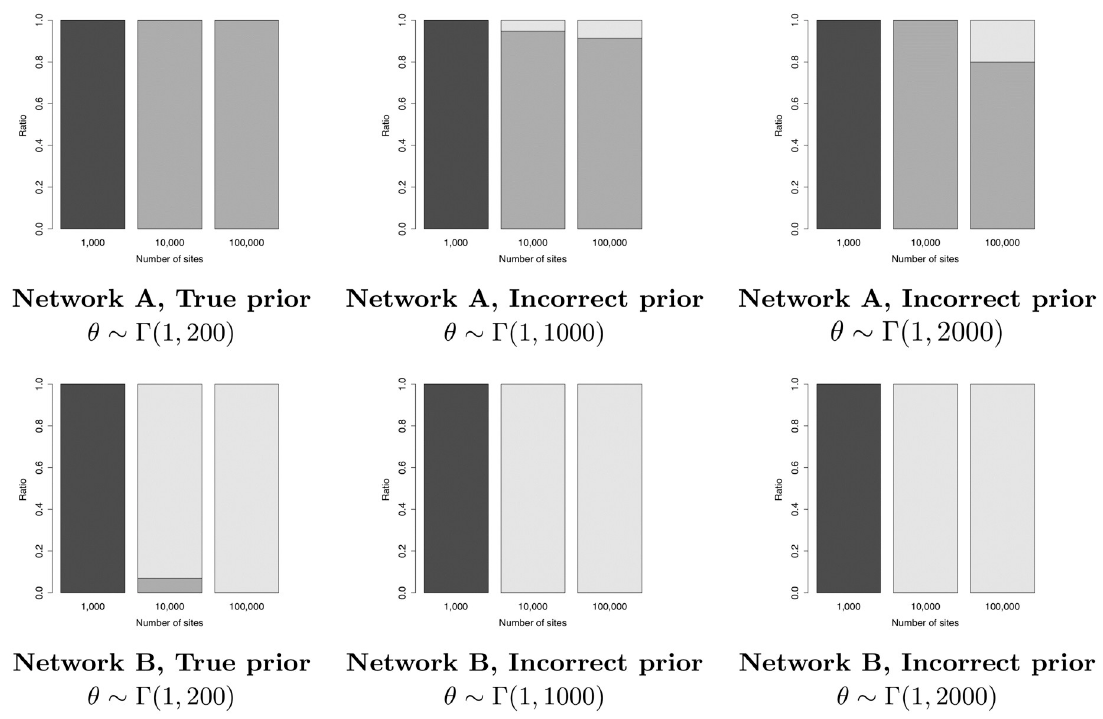
Fig 9. The ratio of trees (black), 1-reticulation networks (dark grey), 2-reticulations networks (light gray), sampled by S NAPP N ET , under the different simulations settings studied in Table 1. Recall that networks A and B contain 1 and 2 reticulations,